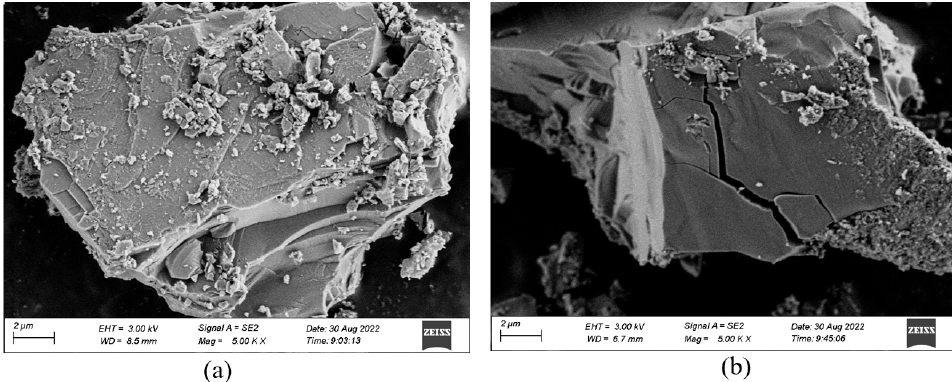
Figure 3. Internal micro-structure of the concrete specimens after 0 ( a ) and 150 ( b ) freeze–thaw